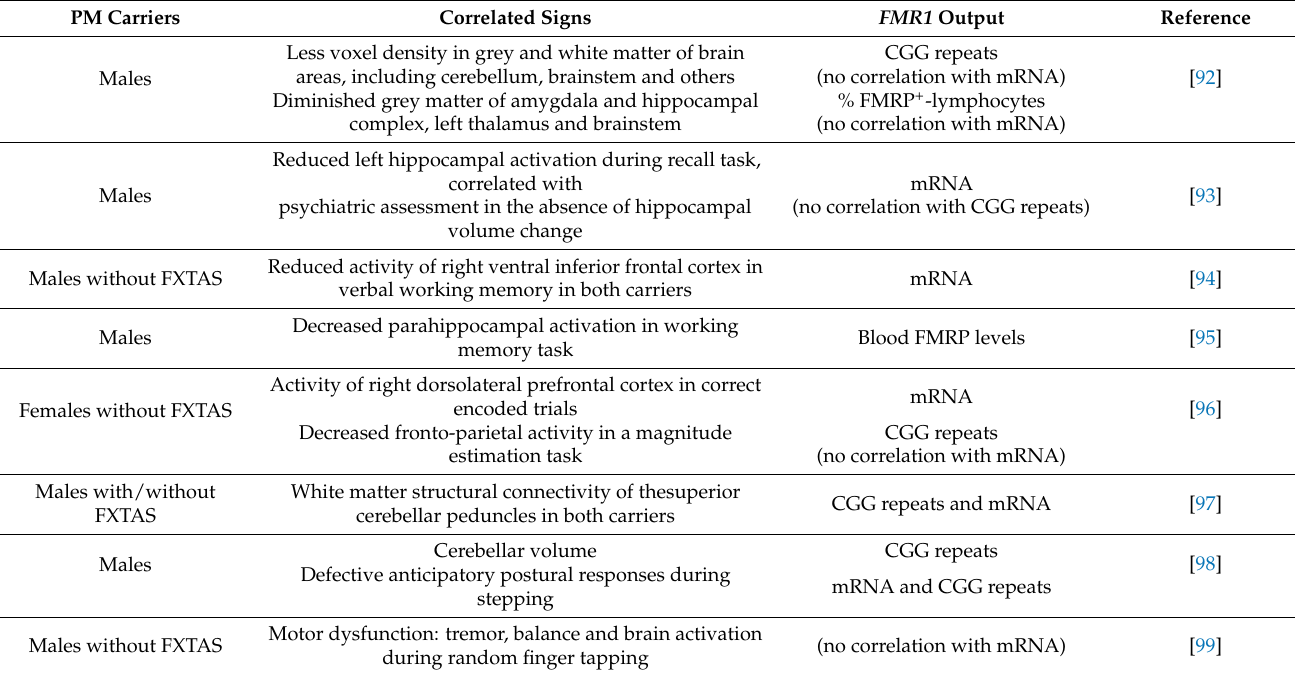
Table 1. Studies conducted in PM carriers searching for correlation between brain imaging measurements and FMR1 -derived parameters: number of CGG repeats, FMR1 mRNA levels and FMRP